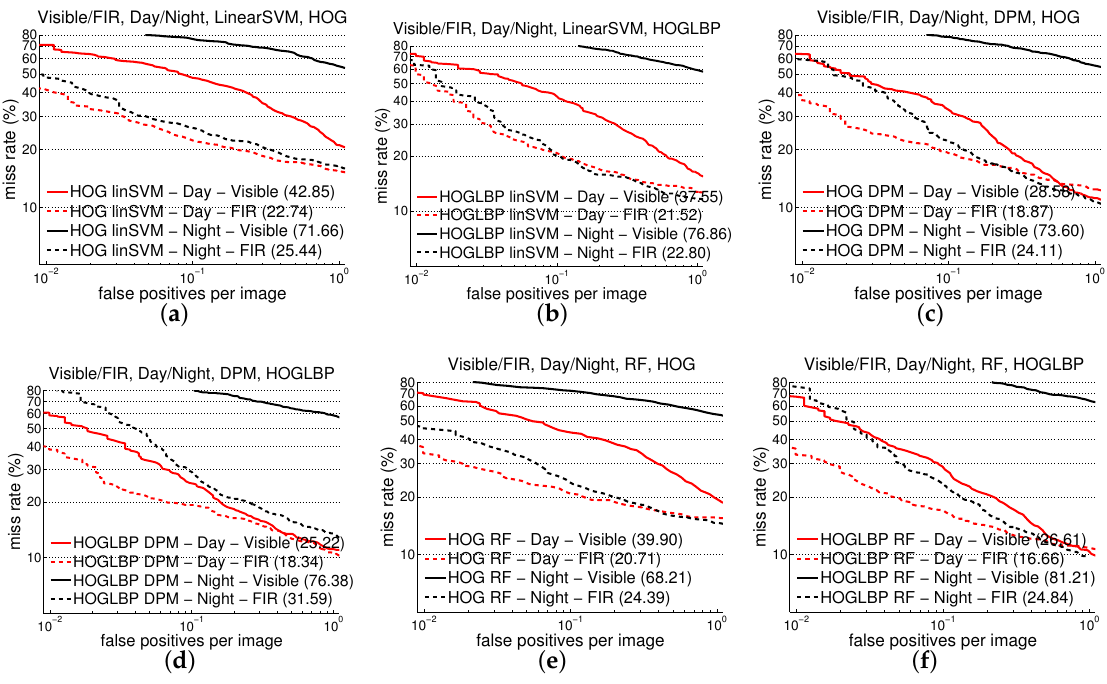
Figure 3. Results using different detectors over CVC-14 dataset. First row plot results using detectors based on ( a ) SVM/HOG, ( b ) SVM/HOG + LBP, ( c ) DPM/HOG, ( d ) DPM/HOG + LBP, ( e ) RF/HOG and ( f ) RF/HOG +